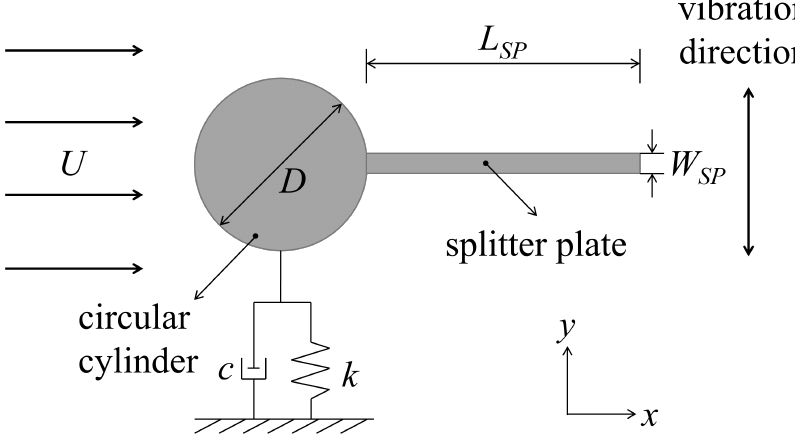
Figure 1. Sketch of a splitter plate attached to an elastically mounted circular cylinder constrained to oscillate in the transverse ( y -)